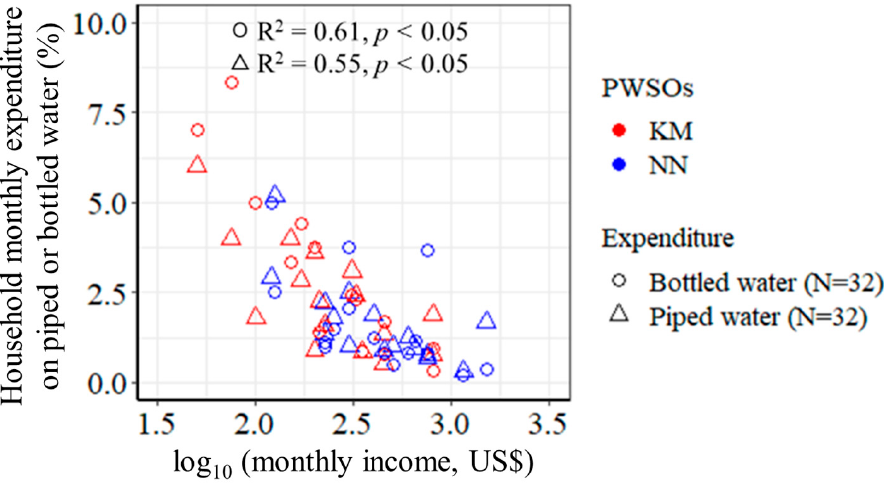
Figure 7. Correlation between log monthly income and percentage of household expenditure on piped or bottled water. piped or bottled